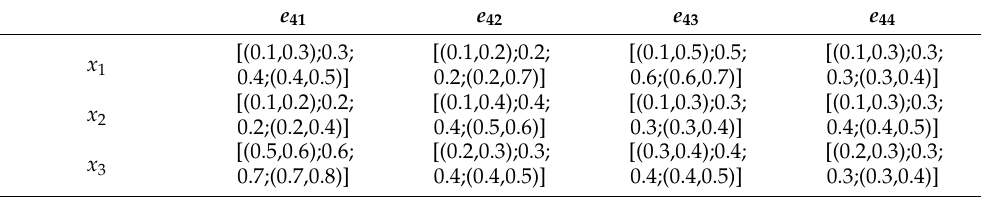
Table A13. The different risk evaluation values subordinated by influencing factors of B 4 at time t 3